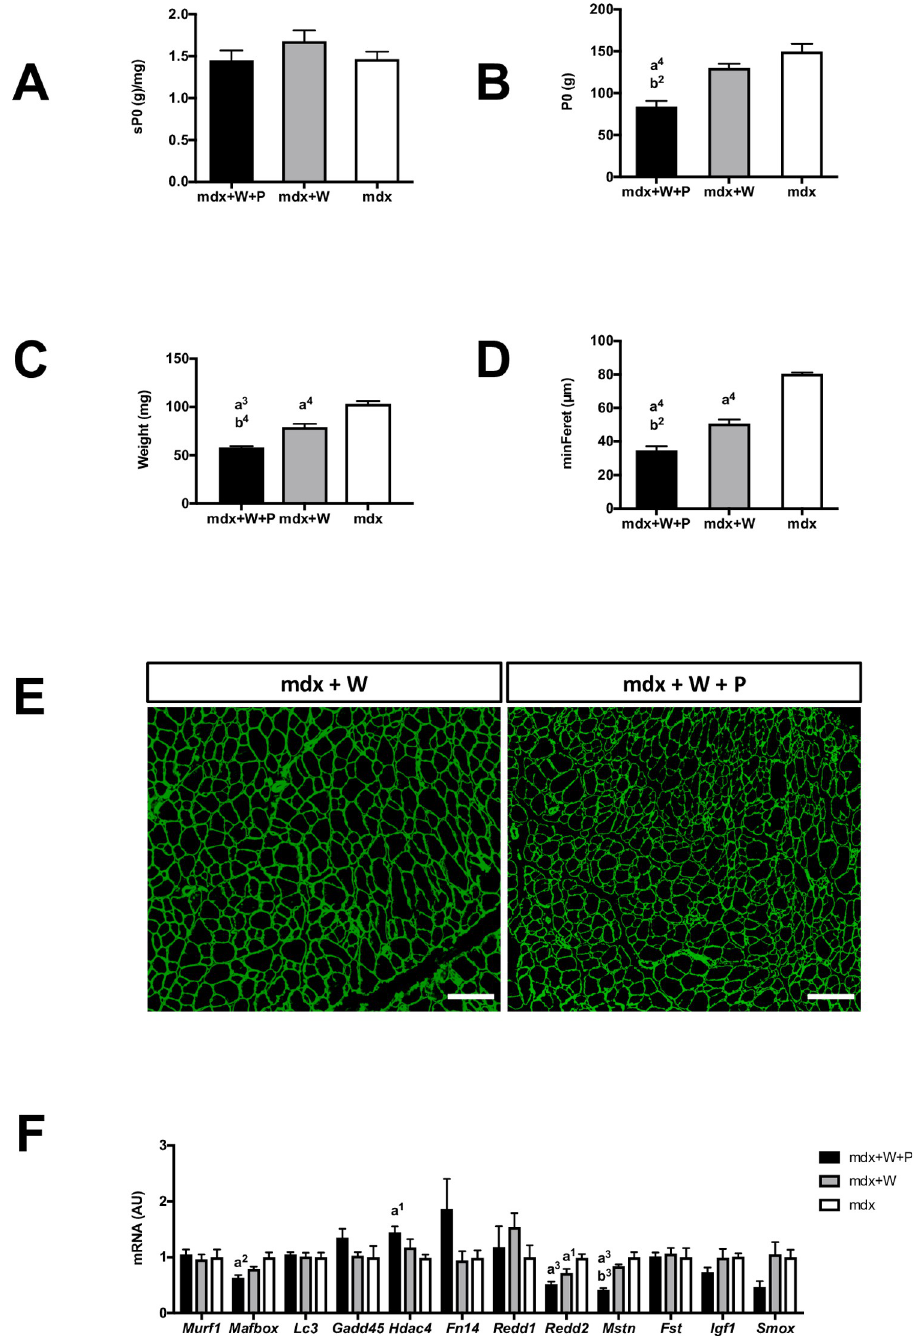
Fig 4. Effect of Prox1 transfer on absolute (P0) and specific (sP0) maximal forces, muscle weight and gene expression of atrophy markers in voluntary exercised mdx mice (first set of experiment). (A) Specific maximal force in Mdx+W+P Mdx+W+P and Mdx+P muscle. n = 6–8 per group. (B) Absolute maximal force in Mdx+W+P and Mdx+P muscle. n = 6–8 per group. (C) Muscle weight in Mdx+W+P and Mdx+P muscle. n = 6–8 per group. (D) Fibre diameters (min feret) in Mdx+W+P and Mdx+P muscle. n = 3–4 per group. (E) Representative image of muscle cross- section. Fiber outline was visualized by antilaminin antibody (green). Scale bar = 200 μ m. (F) Expression of genes related to atrophy in Mdx+W+P and Mdx+P muscle. N = 6–8 per group. Mdx+W+P: voluntary exercised mdx muscle that received Prox1 transfer into the muscle. Mdx+W: voluntary exercised mdx muscle. Mdx: Mdx muscle. a1, a2, a3, a4: significant different from Mdx, p < 0.05, p < 0.01, p < 0.001, p < 0.0001, respectively. b2, b3, b4: significant different from Mdx+W, p < 0.01, p < 0.001, p < 0.0001, respectively.